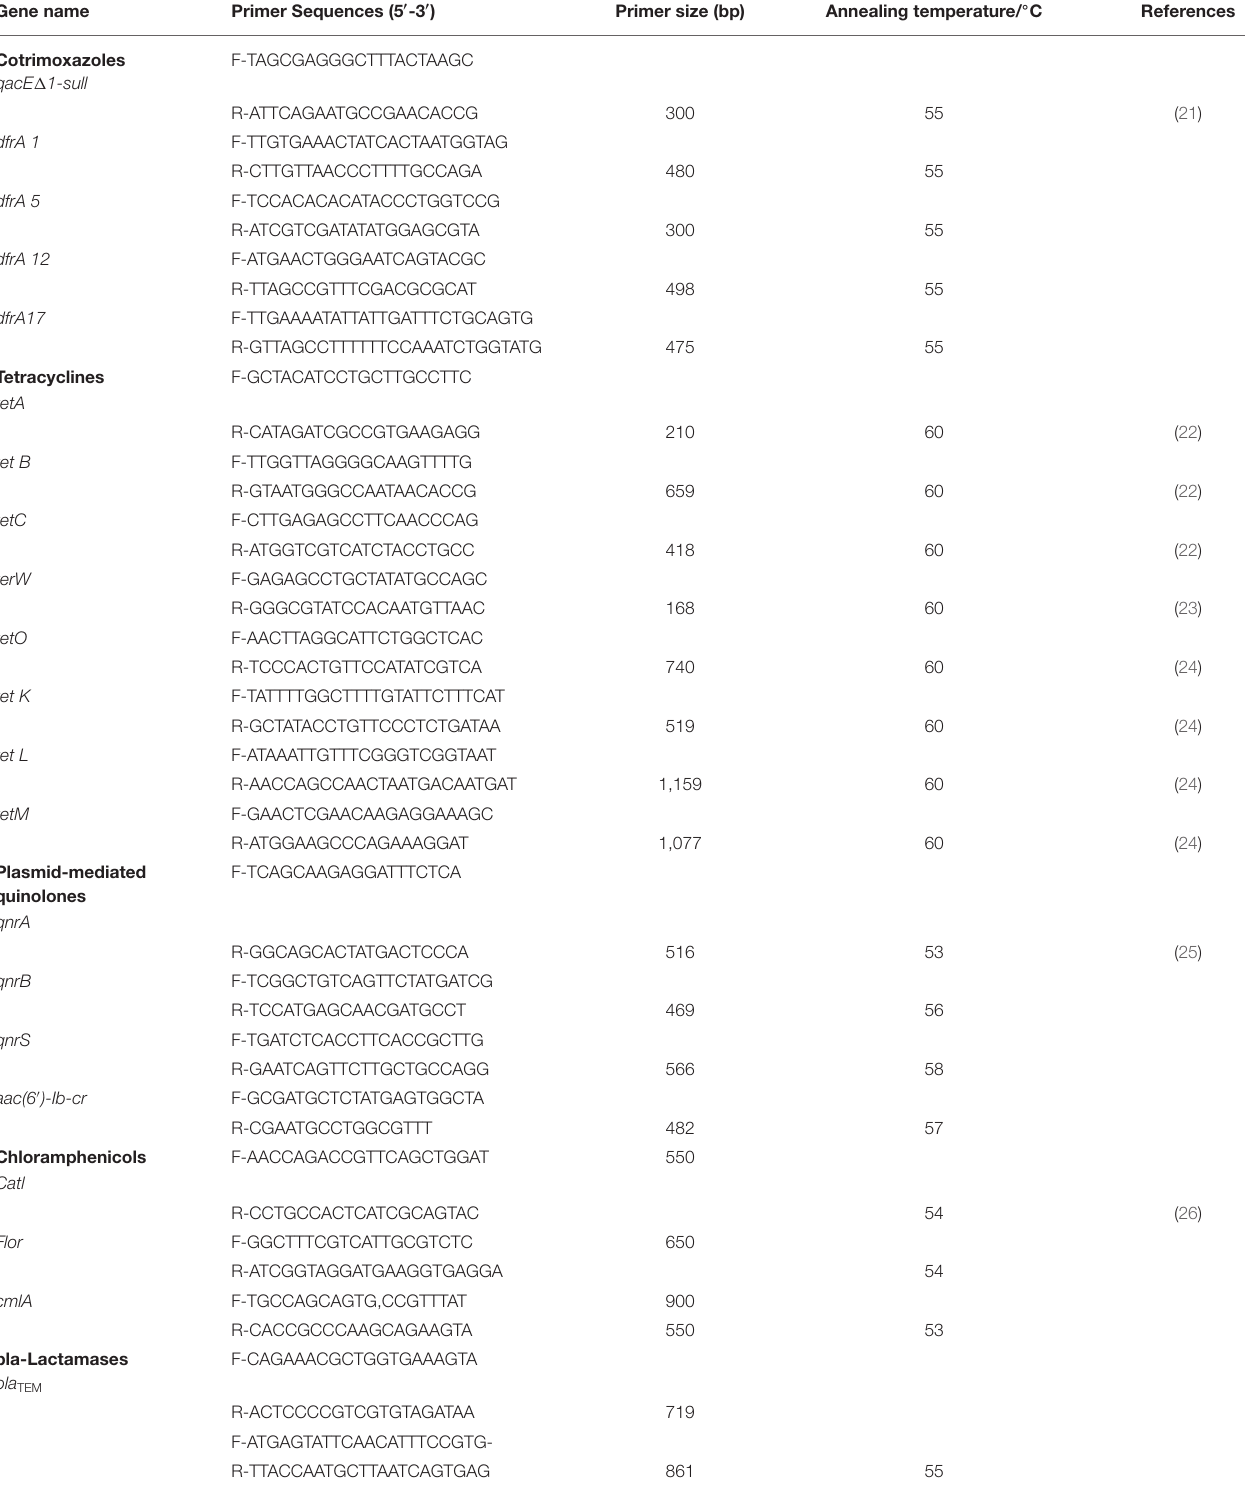
TABLE 2 | Tested genes and their specific primer